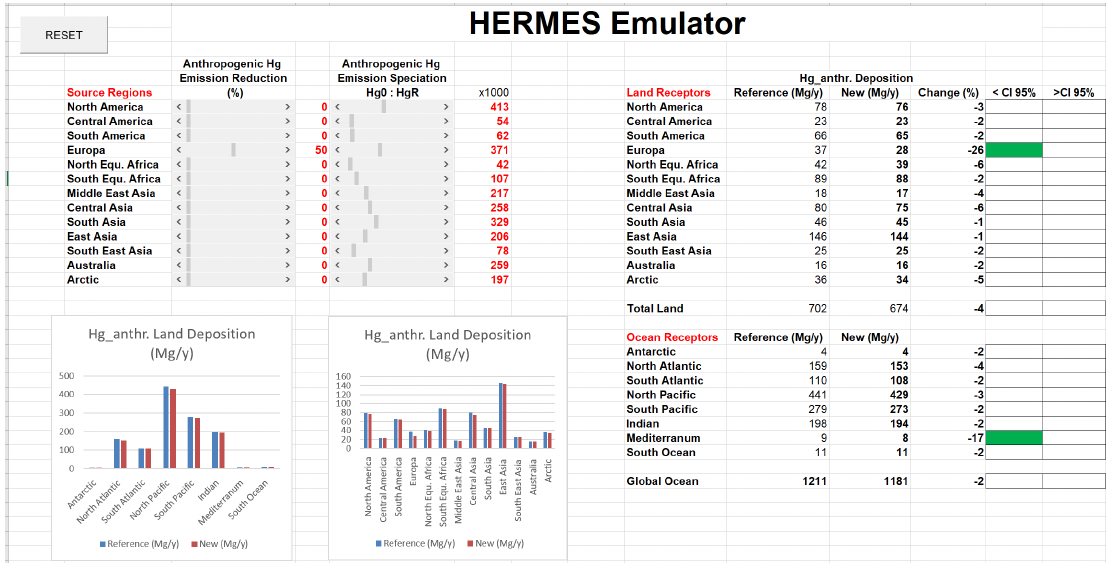
Figure 4. Use-case 2: Hg